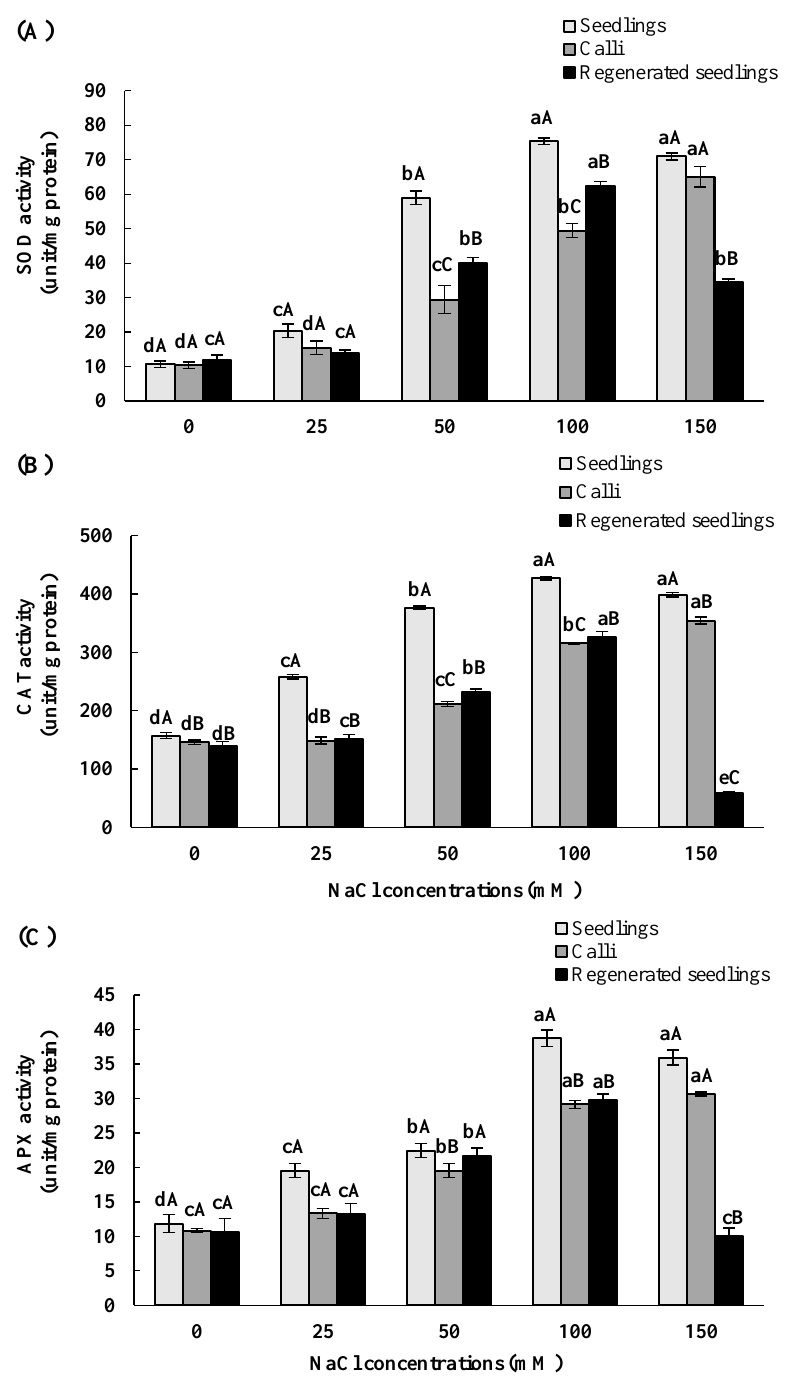
Figure 5. Effect of salinity on antioxidant enzyme activity of Carum copticum. Mature sterilized seeds and regenerated seedlings were grown on MS medium containing 0, 25, 50, 100, and 150 mM NaCl. Calli were cultured on MS medium containing 1 mg L − 1 BAP, 0.25 mg L − 1 2,4-D, and the above-mentioned concentrations of NaCl. The activities of SOD ( A ), CAT ( B ), and APX ( C ) were measured using 4-week shoots of salt treatment. Values represent the mean of three replicates with error bars indicating ± standard errors. Different lowercase letters indicate significant differences among the 5 NaCl concentrations in an explant of Carum copticum, and different uppercase letters indicate significant differences among 3 explants of Carum copticum within the same NaCl level according to Duncan’s test p ≤ 0.05.